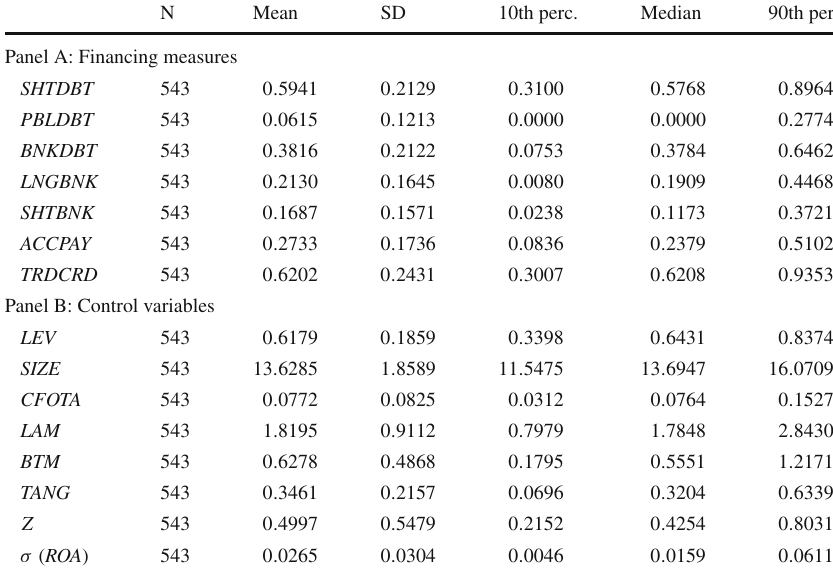
Table 3 Descriptive statistics of dependent and control